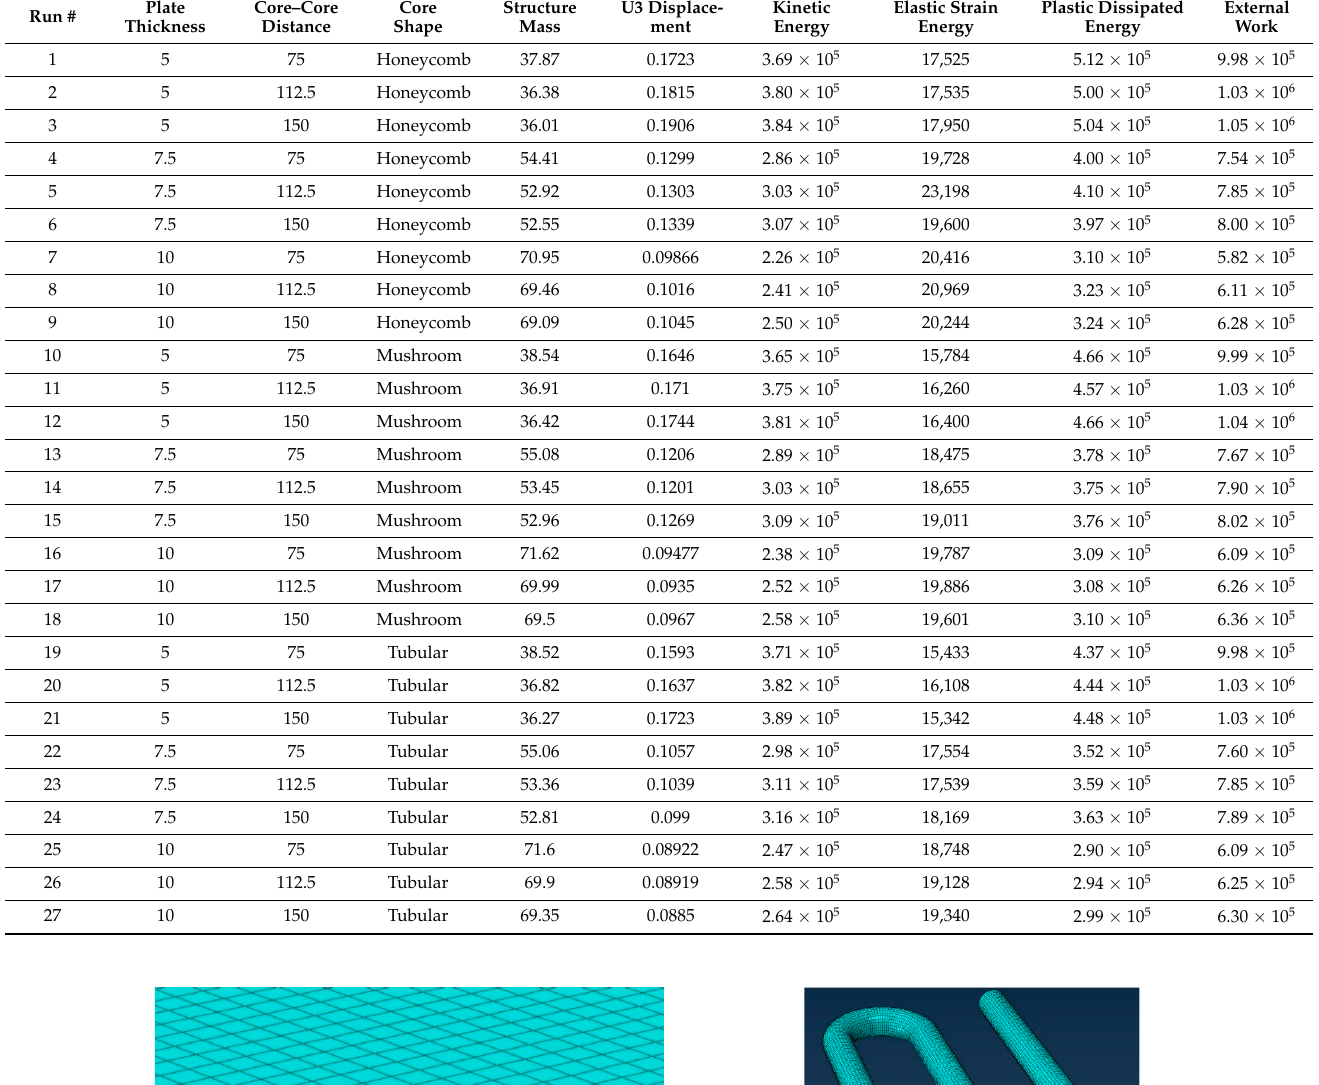
Table 1. Design of experiment (DOE) and numerical model responses.